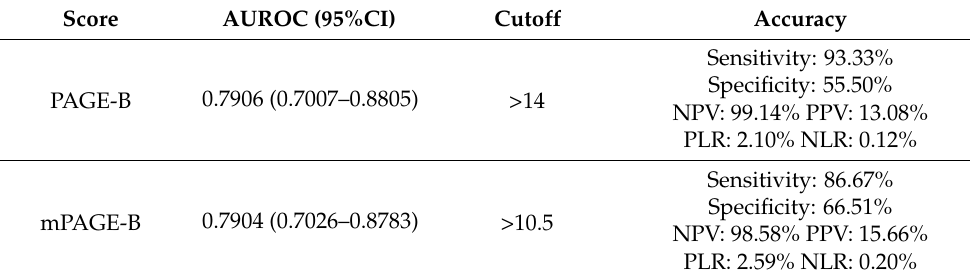
Table 5. Performance of the initial scores in hepatocellular carcinoma